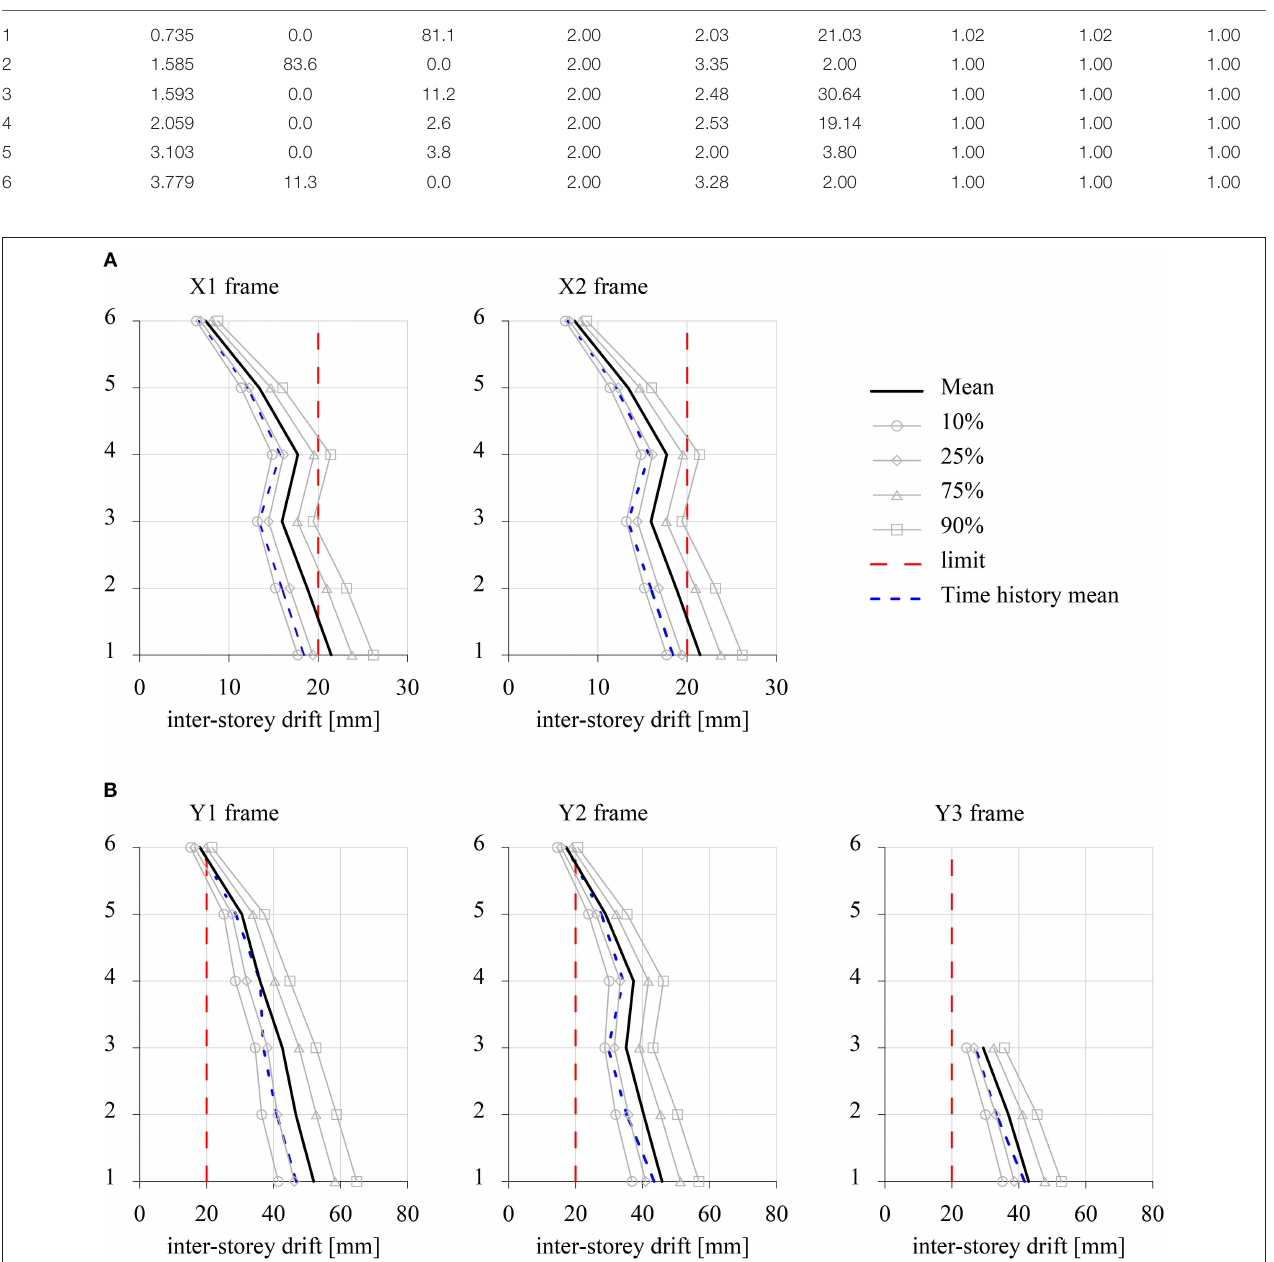
FIGURE 7 | Peak values of inter-story drifts of the Model 2 uncontrolled system. (A) θ